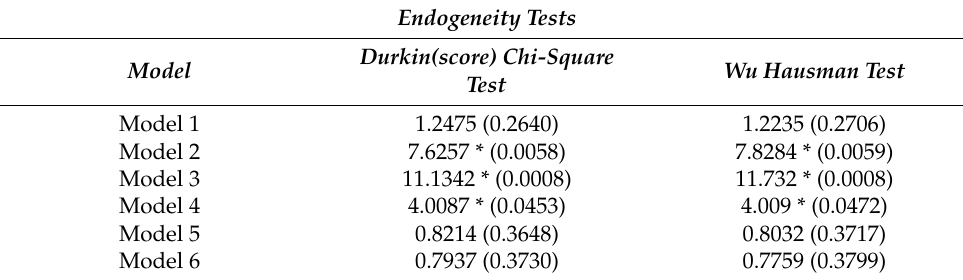
Table 9. Endogeneity